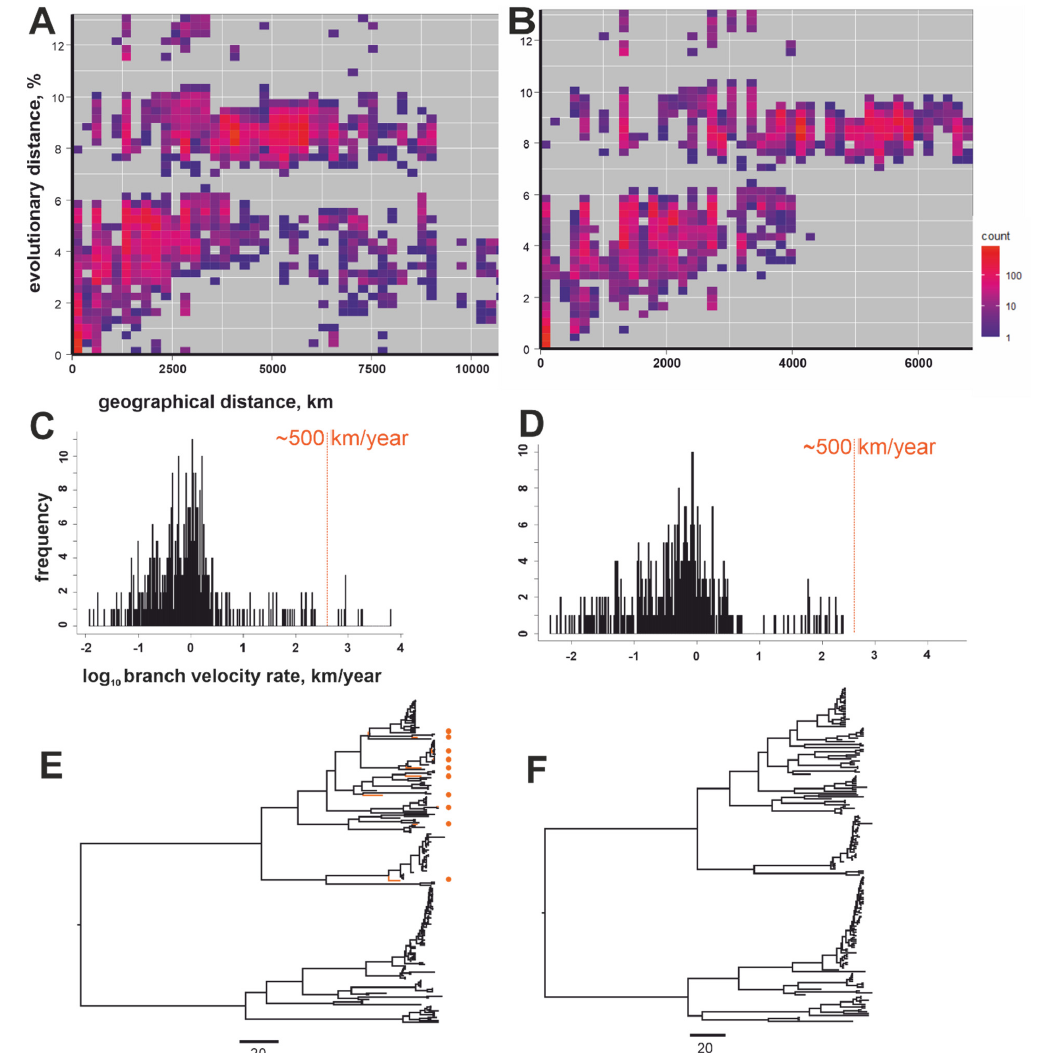
Figure 3. ( A ) Gene-geo plot for the Arctic-like RABV group ( n = 201). ( B ) Gene-geo plot for Arctic-like RABV group without sequences of viruses apparently transferred between distant regions (#EU836832, #MG011654, #AY956319, #KF154996, #KU963488, #FJ228546, #KY982922, #EF611869, #KY860613). These nine sequences and 16 more sequences that were iden- tical in more than 99.7% of nucleotides and whose collection sites were at a distance of at least 500 km were omitted from the alignment, yielding 176 sequences. ( C , D ) The distribution of the inferred velocity rates at the branches of MCC (max- imum clade credibility) phylogenetic trees ( E , F ) in log-scale for all Arctic-like RABV group sequences (( C , E ) n = 201) and Arctic-like RABV group sequences without a putative long-distance transfer history (( D , F ) n = 176). The orange line indi- cates a velocity of 500 km/year. Tree branches with velocity rates over 500 km/year are shown in orange and marked with orange circles.